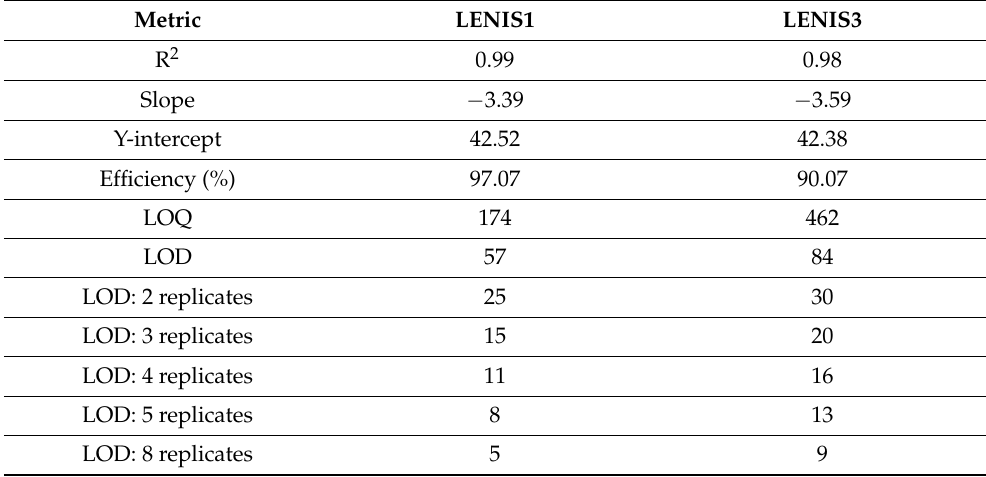
Table 4. Standard curve (six-level; fourfold) regression coefficients, quantification reliability (effi- ciency and LOQ), and sensitivity estimates (LOD via probit modeling). Estimates of LOD and LOQ reflect copy numbers per reaction. Copy numbers have been rounded up to the nearest integer.